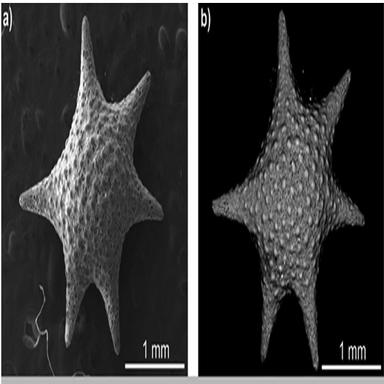
Topographic images of the diatom shell made via SEM: a). SEM image of the selected type of the diatom shell using a secondary electron detector; b). SEM image of the selected type of the diatom shell using the back-scattered electron detector; c). and d). higher magnification of the selected area of the diatom shell using the secondary electron detector; and e). SEM image of the diatom shell fragment with the marked area of the thin foil prepared for TEM cross-sectional observation.